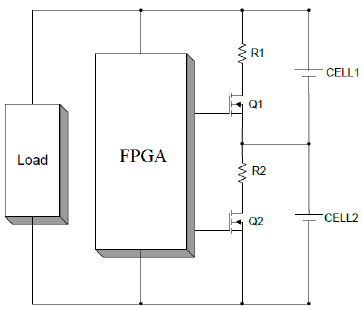
Figure 5. Smart battery pack diagram with cell-balancing.